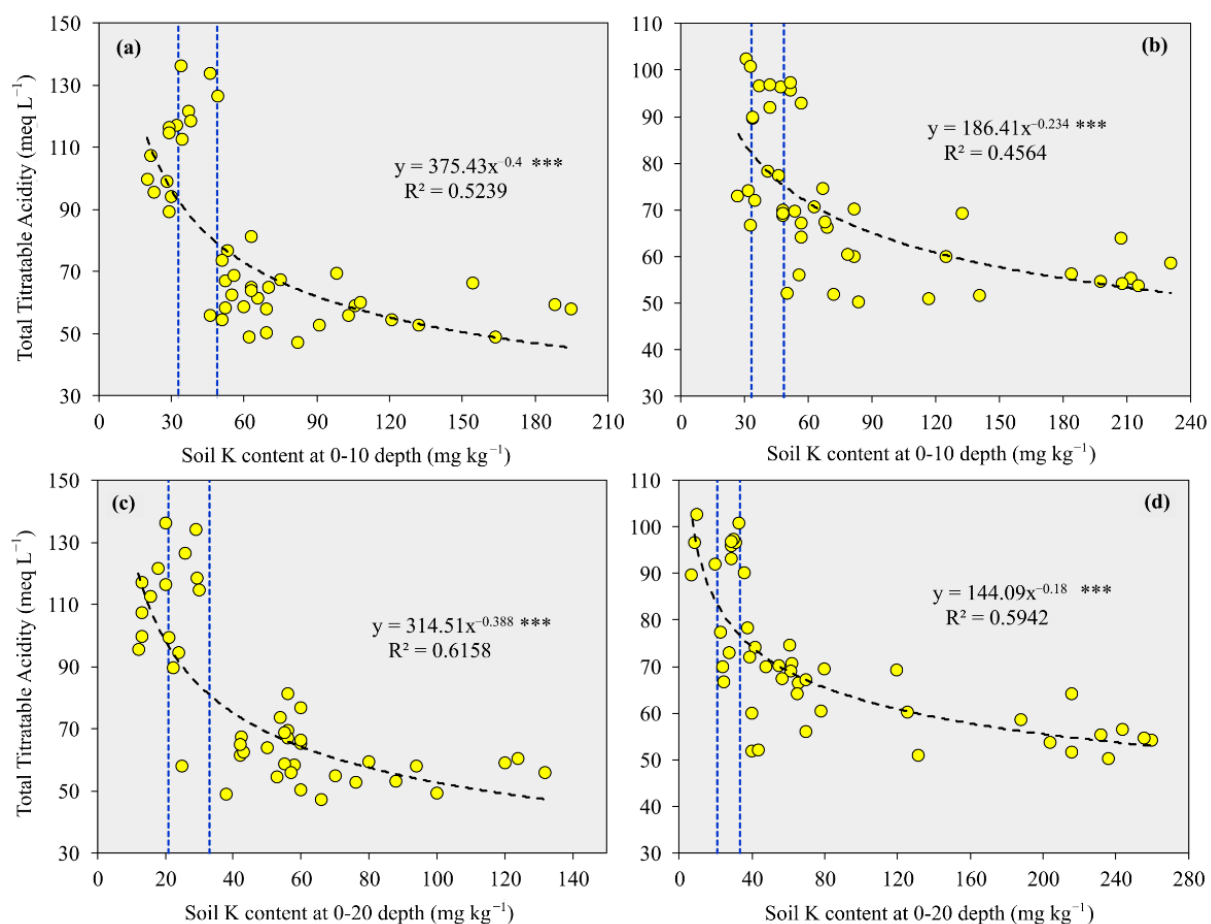
Figure 8. The relationship between the soil K content and the total titratable acidity (TTA), in the evaluated crops seasons, in ‘Chardonnay’ ( a , c ) and ‘Pinot Noir’ ( b , d ). Vertical blue dotted lines represent the range of probability of occurrence (95% highest density interval) of the CL of K. The black dotted line is the behavior of the equation (TTA variable). “***” Significant at 0.1% ( p <